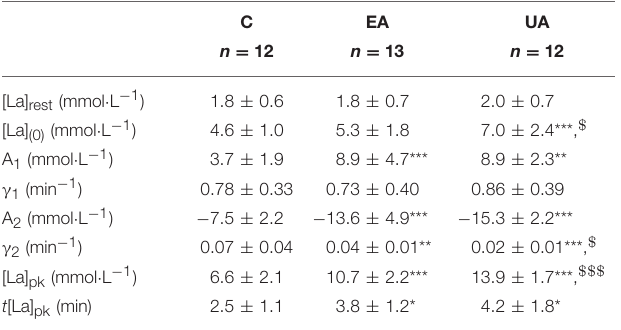
TABLE 3 | Blood lactate kinetics parameters obtained during the recovery period of the Wingate test in prepubertal children, untrained adults and well-trained adult endurance athletes.